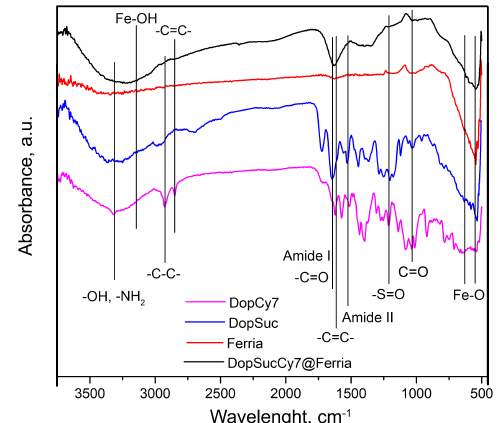
Figure 4. FTIR spectra of the synthesized